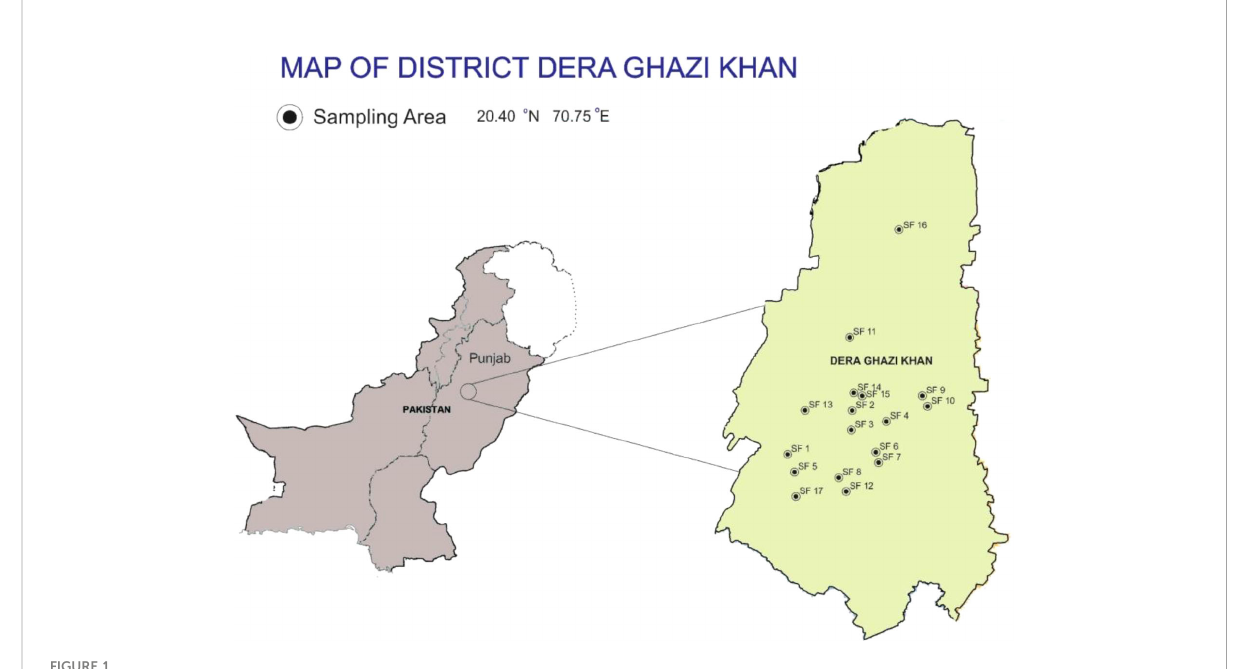
FIGURE 1 Map of Dera Ghazi Khan District showing sampling